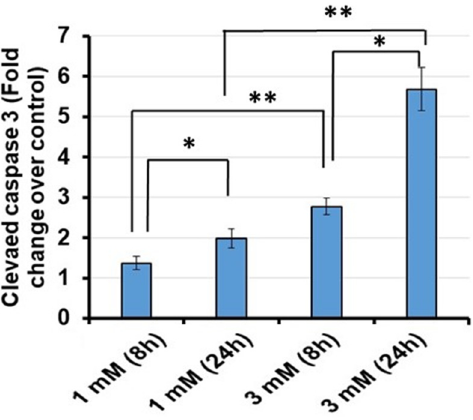
Figure 5. Cleaved caspase 3 immunostaining: ( A ) Representative photomicrographs showing cleaved caspase 3 expression levels in HEI-OC1 cells treated with gentamicin. Red: cleaved caspase 3; Blue: cell nuclei. Scale Bars: 20 µM; ( B ) ImageJ software was used to determine mean signal in- tensity for cleaved caspase 3 immunostaining. * p < 0.05 or ** p < 0.01.